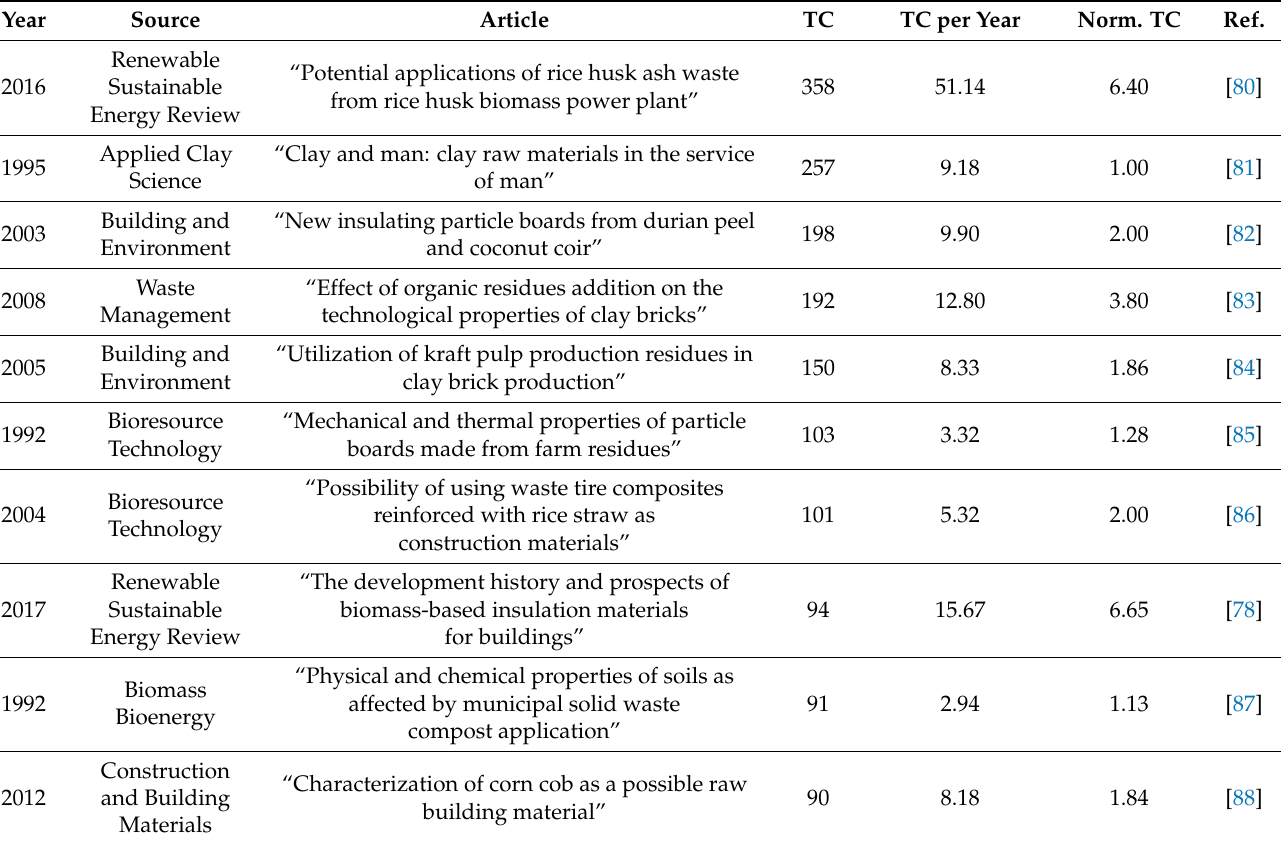
Table 6. Top 10 most globally cited